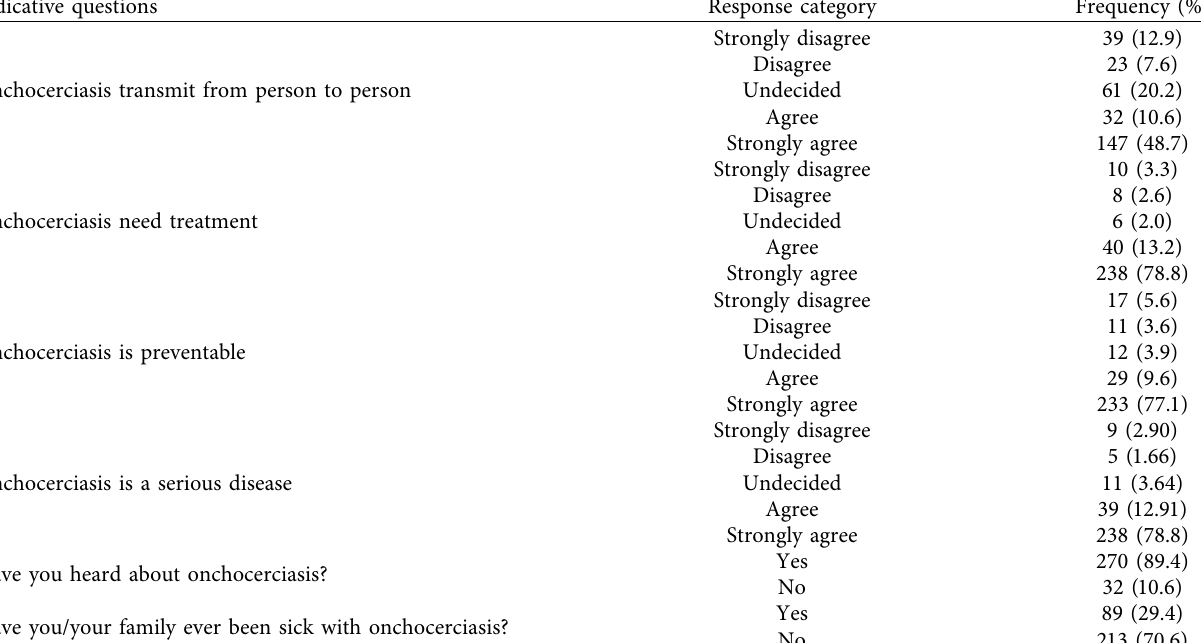
Table 2: Knowledge of respondents about the transmission, prevention, and treatment of onchocerciasis from Gesha town, Ethiopia. Indicative questions